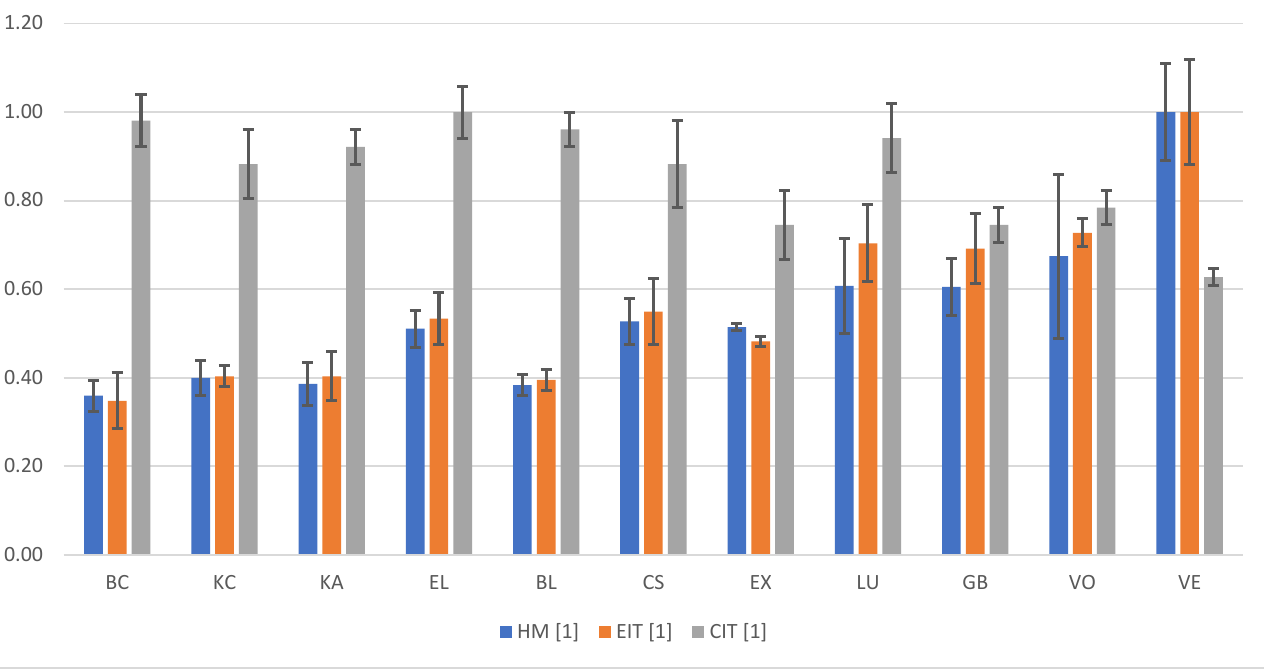
Figure 3. Martens hardness (H M ), indentation modulus (E IT ), and indentation creep (C IT ) scaled to percentage of maximum value. Materials ordered by increasing amount of inorganic filler content.